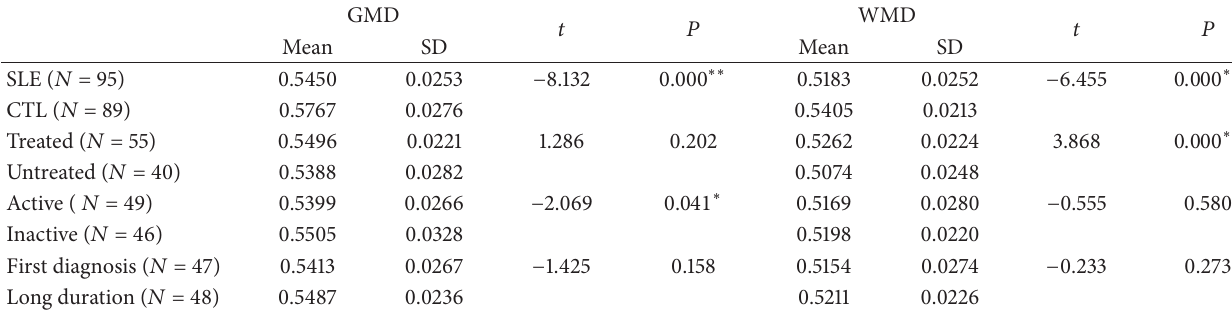
Table 2: Comparison of GMD/WMD.